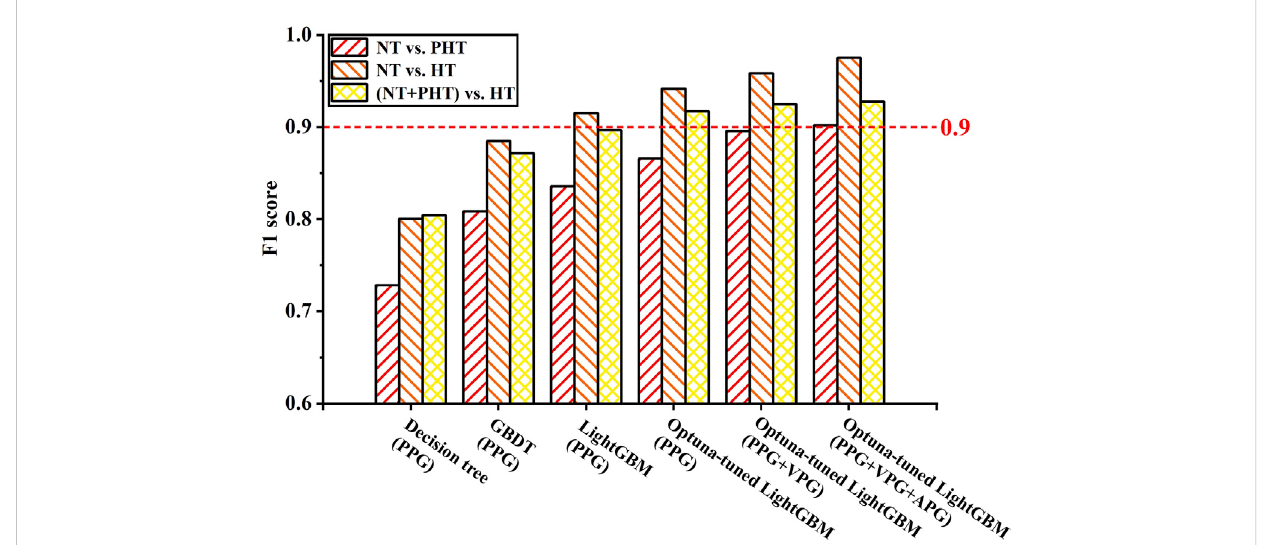
FIGURE 5 Performance of the model with different feature sets. Note, NT, PHT, and HT represent normotension, prehypertension, and hypertension, respectively. PPG, VPG, and APG denote photoplethysmography, velocity plethysmography, and acceleration plethysmography,